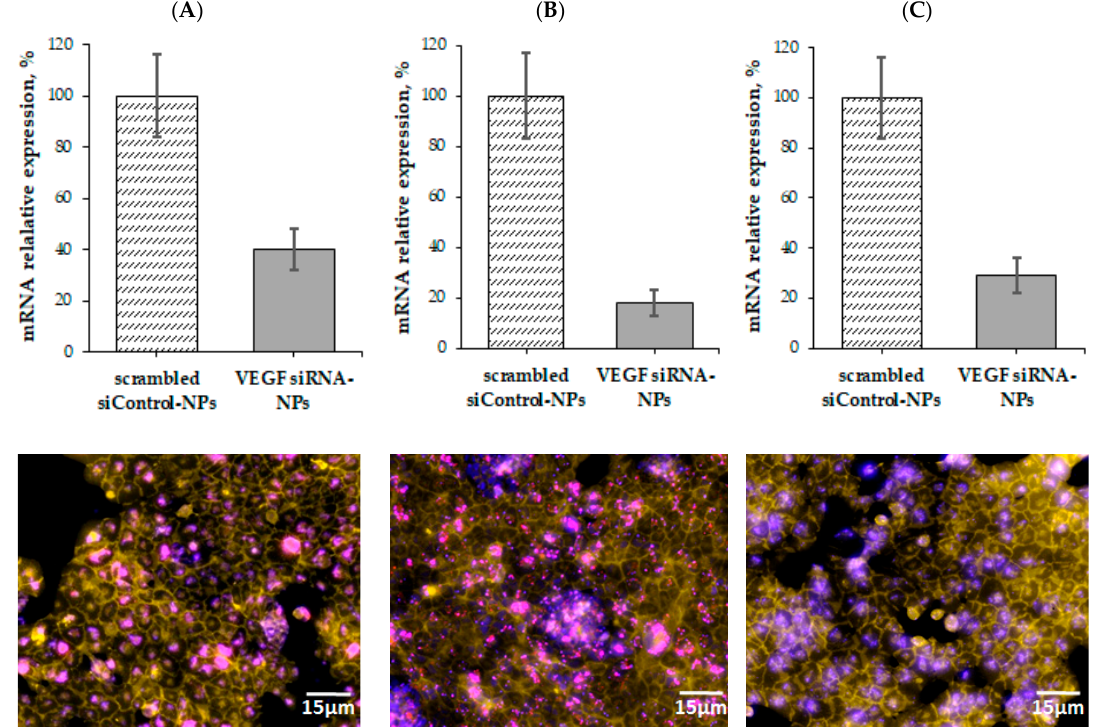
Figure 6. mRNA interference by anti-VEGF siRNA delivered by KEF1 ( A ), KEI1 ( B ) and KEI2 ( C ) nanoparticles (polymer:siRNA ratio = 4:1) in the ARPE-19 cells (mean ± SD, n = 3). Cell membranes were stained with Cell Mask Green Plasma Membrane dye (green-yellow color), cell nuclei were stained with Hoechst 33,258 (blue color). Cy3 labelled siRNA was depicted in pink color.